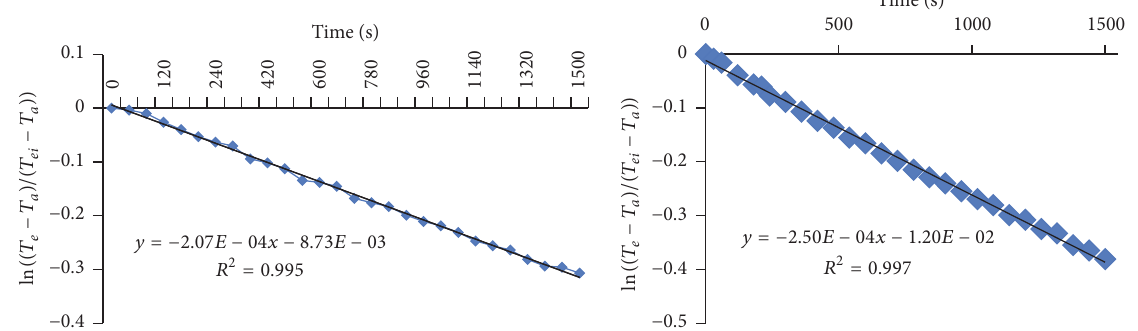
Figure 4: Graphic determination of the overall coefficient of heat loss calorimeter.